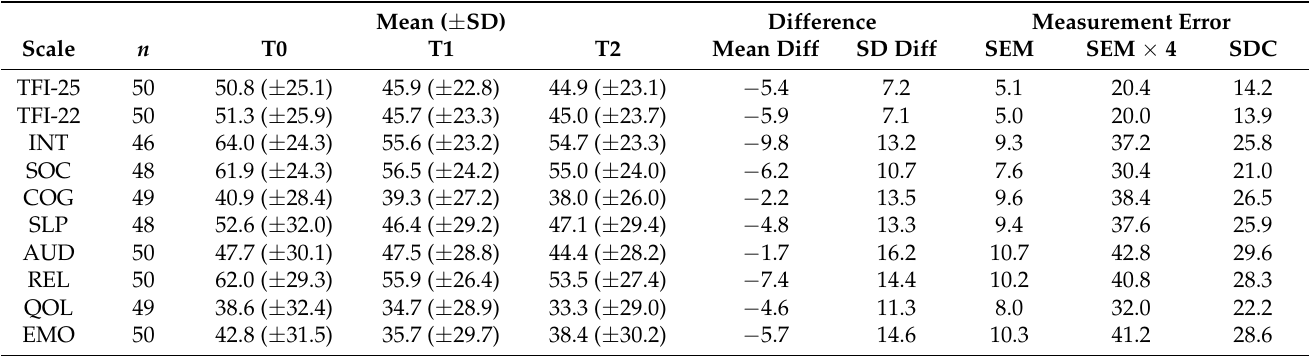
Table 2. Smallest Detectable Change (SDC) and Standard Error of Measurement (SEM) for Tinnitus Functional Index (TFI/TFI-22) scores between three administrations.